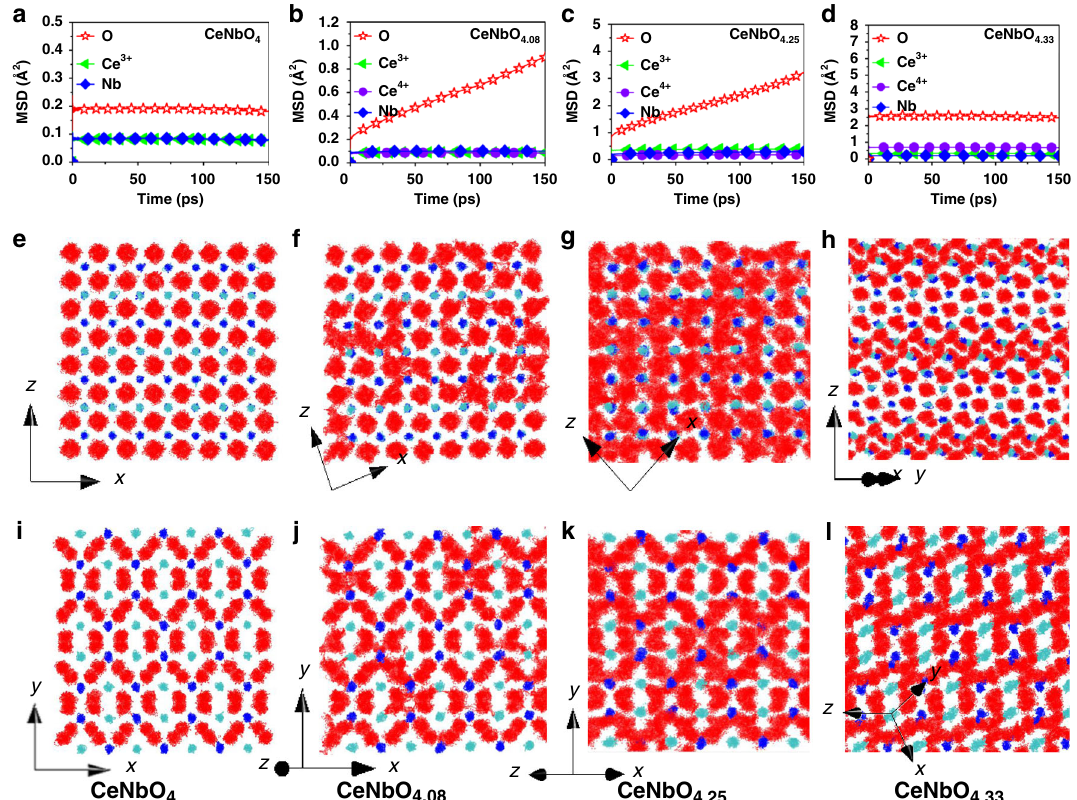
Fig. 5 Molecular dynamics simulations study of CeNbO 4 + δ . Calculated MSD values of Ce 3 + /4 + , Nb, and O atoms as a function of simulation time for CeNbO 4 ( a ), CeNbO 4.08 ( b ), CeNbO 4.25 ( c ), and CeNbO 4.33 ( d ) from the MD simulation at 1200 °C. Trajectory scatter plots for CeNbO 4 ( e , i ), CeNbO 4.08 ( f , j ), CeNbO 4.25 ( g , k ), and CeNbO 4.33 ( h , l ) at 1200 °C where cyan, blue, and red dots represent Ce 3 + /4 + , Nb 5 + , and O 2 − atoms,